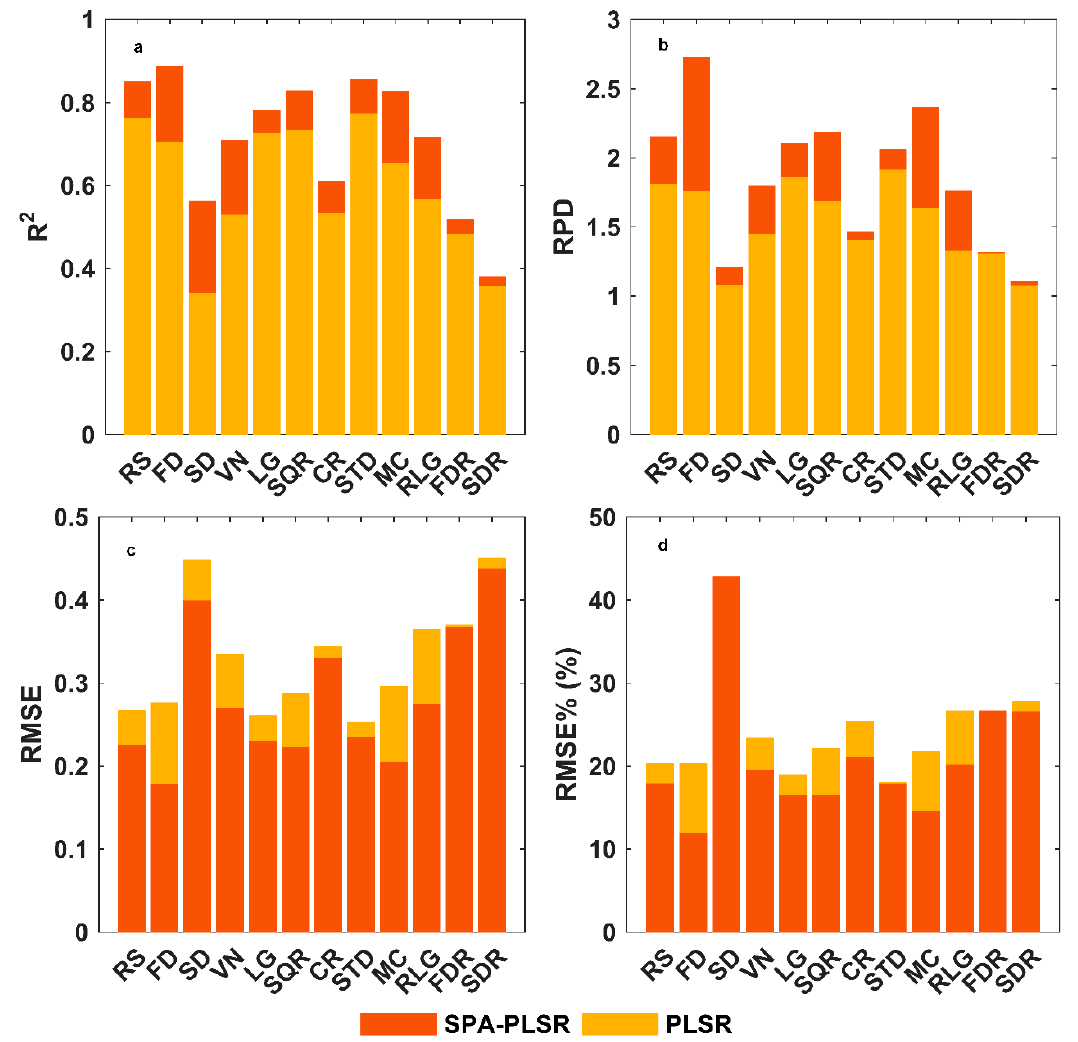
Figure 11. Comparison of the SPA–PLSR and PLSR results. ( a ) Shows the change in R 2 ; ( b ) shows the change in RPD; ( c ) shows the change in RMSE; and ( d ) shows the change in RMSE%. The red bar chart represents the results of the SPA–PLSR model, the yellow bar chart represents the results of the PLSR model.